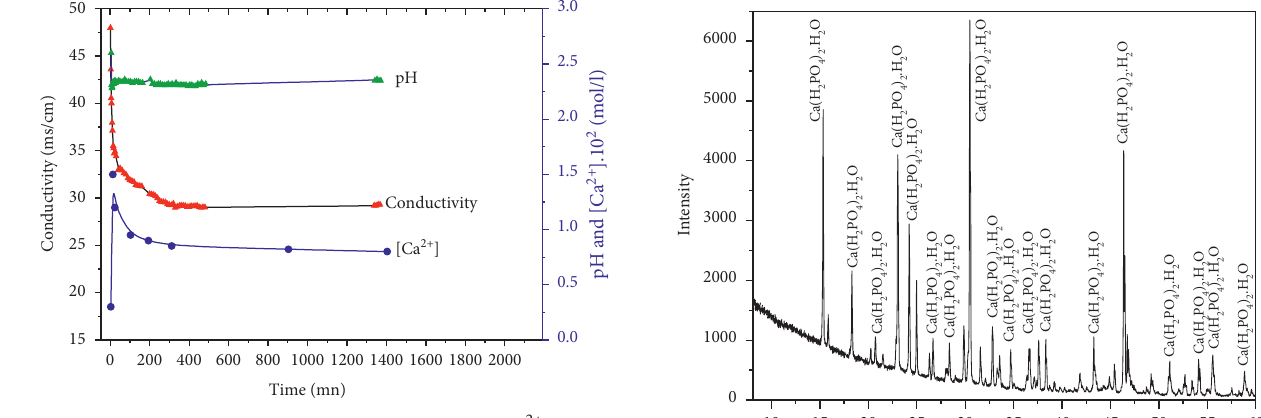
Figure 8: Evolution of the conductivity, pH, and Ca 2+ concen- tration as a function of time of mixture M 4.